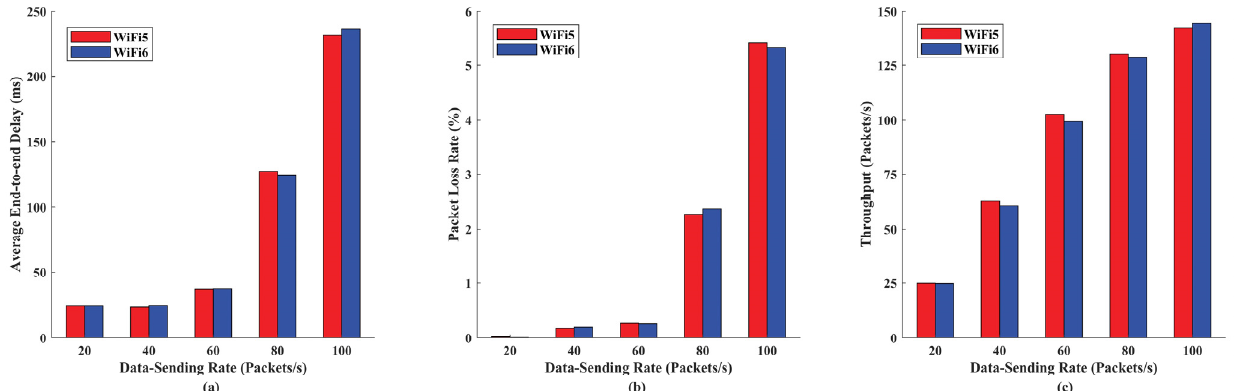
Figure 13. Network performance of the GraphSAGE-based multipath reliable routing algorithm ( a ) Average end-to-end delay at di ff erent data sending rates. ( b ) Packet loss rate at di ff erent data sending rates. ( c ) Throughput at di ff erent data sending rates.